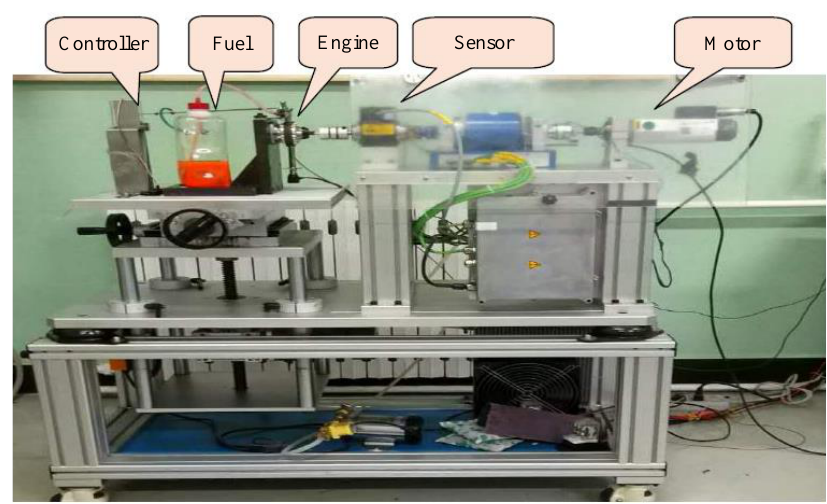
Figure 19. Experimental test platform of micro engine.